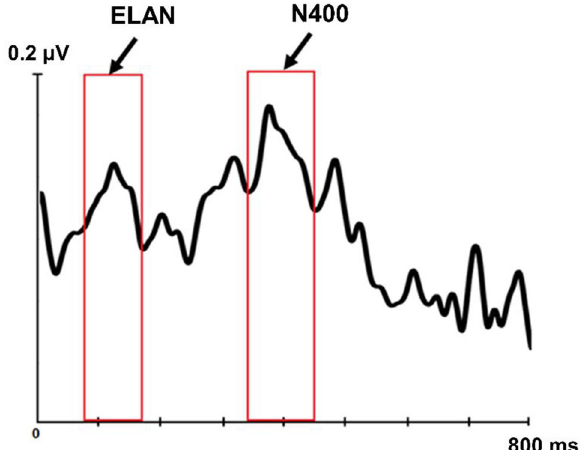
Figure 2. Global Field Power (GFP) waveform, computed across all participants, electrodes, stimuli, and conditions. Red bars highlight two main peaks in the overall neural activity along the ERP segment, maximal at around 150 ms and 400 ms post-suffix